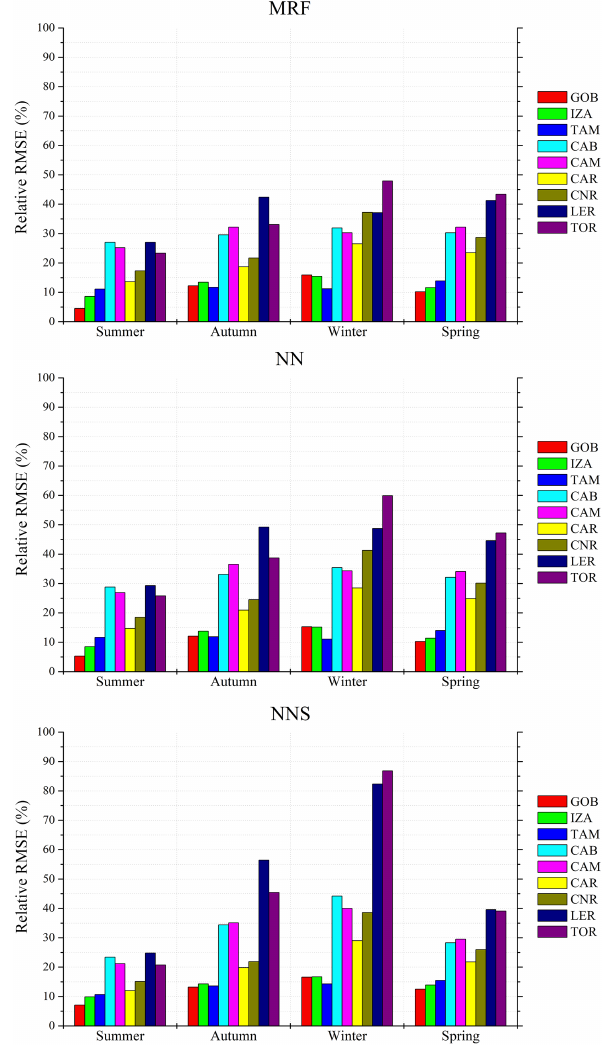
Figure 7. Seasonal relative RMSE values of the GHI estimations produced by the real-time techniques as compared to the BSRN